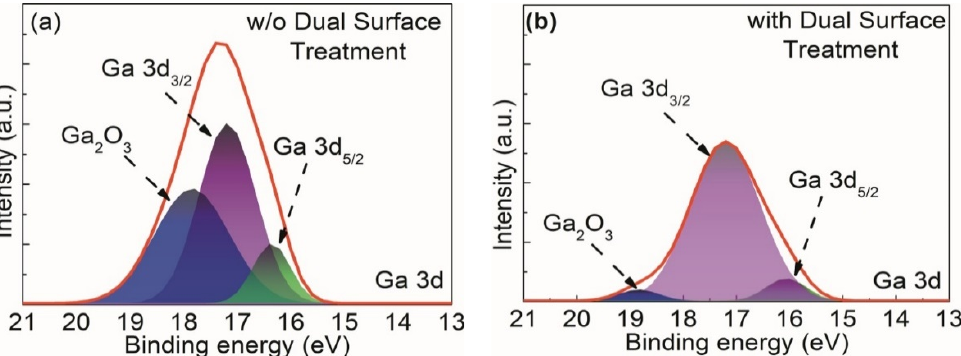
Figure 2. AFM profile of AlGaN/GaN device after ICP mesa etching ( a ) without and ( b ) with TMAH treatment. The 3D AFM images of the device ( c ) without, ( d ) with dual surface treatment and gate annealing modulation.